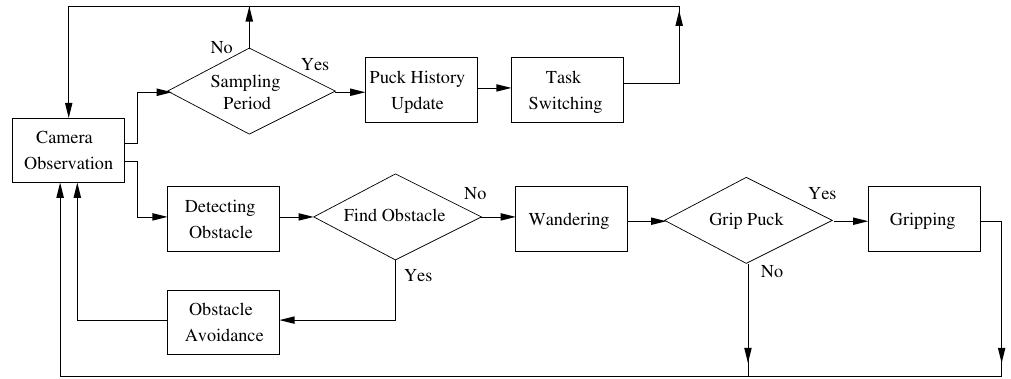
Figure 2. Flowchart of robot